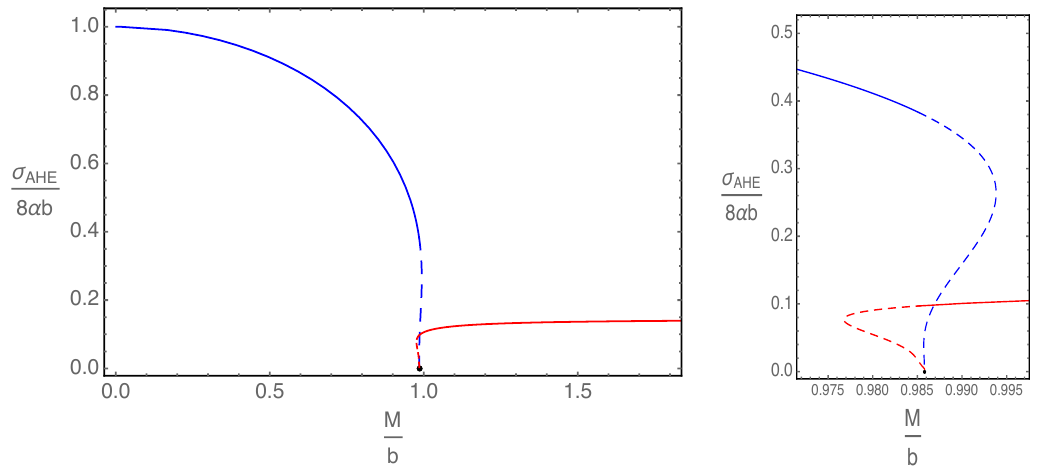
Figure 6 . Both plots are for the zero temperature anomalous Hall conductivity at zero frequency of the holographic system. The right plot is a zoomed in version of the left plot close to the phase transiton point. In both plots, the blue line is for the topological Weyl semimetal phase and the red line is for the Chern insulator phase. The solid and dashed lines are for stable and unstable phases respectively. We see that under the phase transition, the anomalous Hall conductivity is discontinuous and the system undergoes a (cid:12)rst order phase transition from a Weyl semimetal phase to a Chern insulator